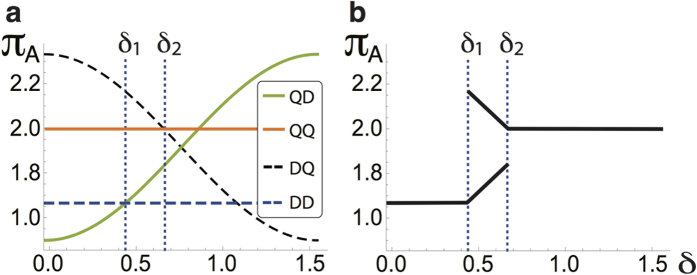
Payoffs for general states ρin(p, δ): (a) the control of the initial state correlations, and  imply thresholds at , and , (b) strategies reaching the Nash equilibrium in the regions defined by δ1 and δ2.